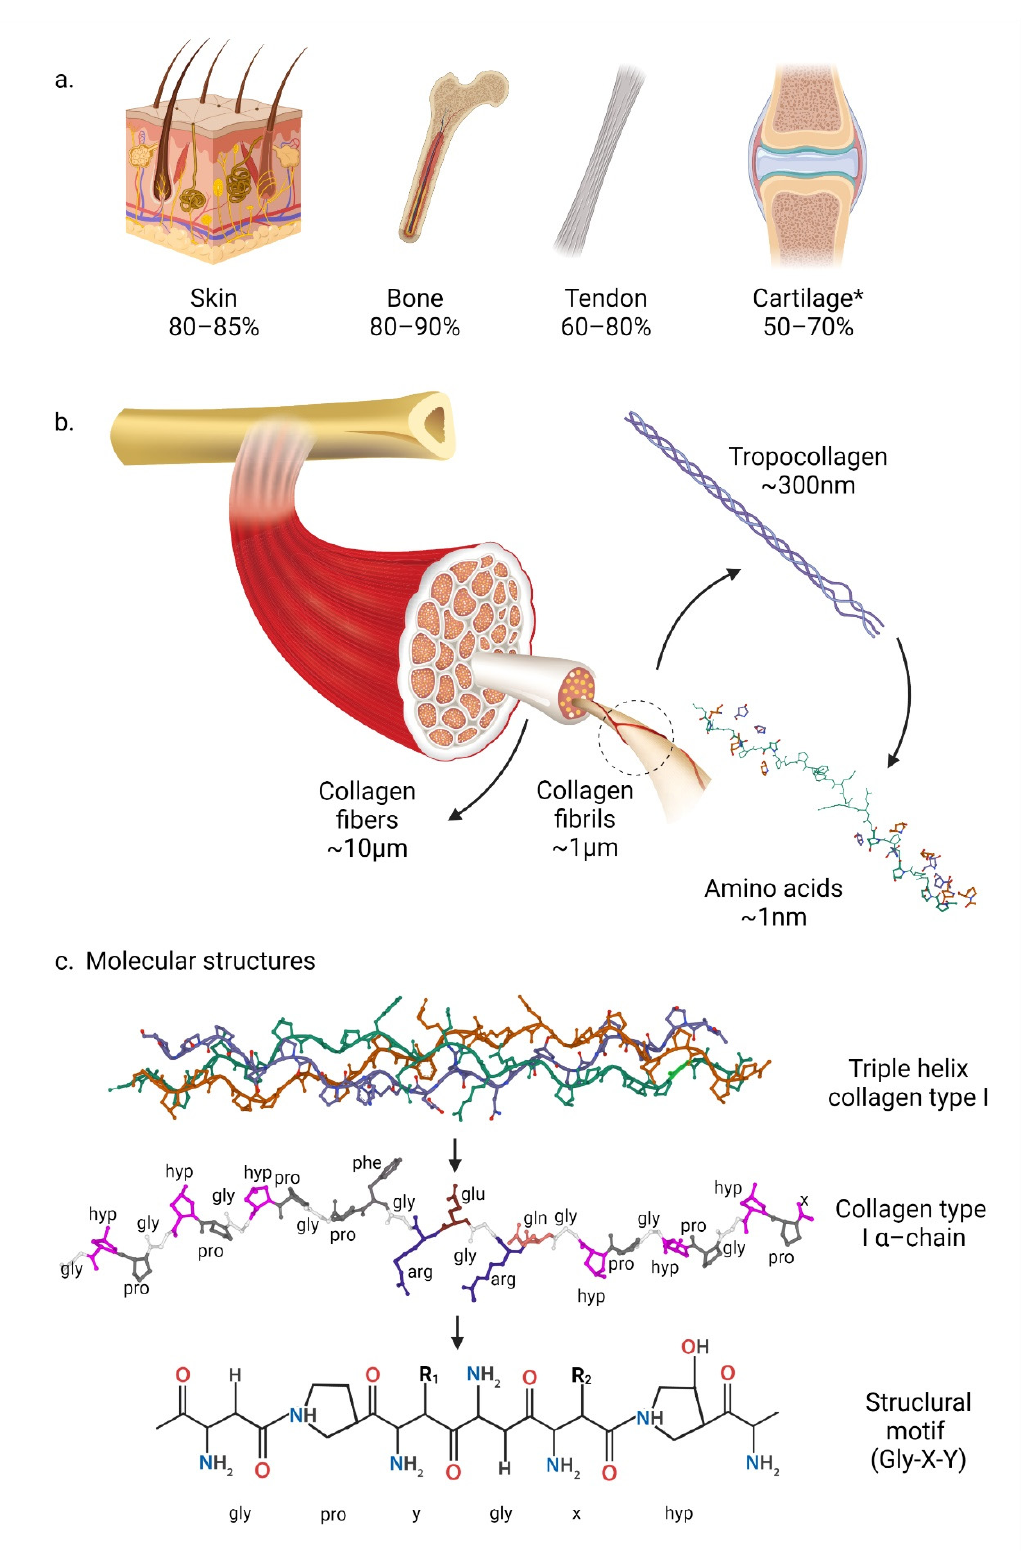
Figure 1. ( a ) Collagen type I sources and approximate content in each tissue. * Cartilage percentage is based on all collagens in their dry weight, as it is predominantly collagen type II. ( b ) Collagen fibre structure, fibrils, triple helices of alpha chains as tropocollagen, and amino acid residues. ( c ) Triple-helix and single-chain collagen type I molecular structure (PDB 1CAG) [24] with gly-x-y repeats; x-y typically represents proline and hydroxyproline,